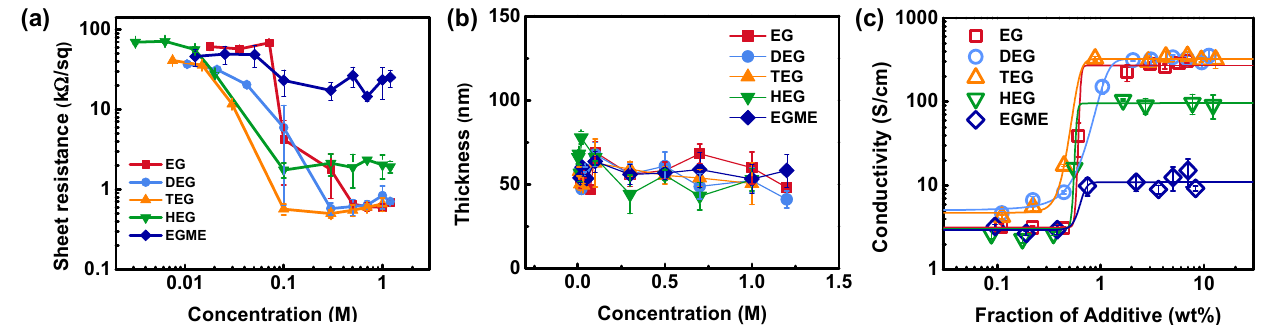
Figure 1. ( a ) Sheet resistance of poly(3,4-ethylenedioxythiophene):poly(styrene sulfonate) (PEDOT:PSS) films processed with linear glycol-based additives at various concentrations. ( b ) Film thickness of PEDOT:PSS films processed with the additives. ( c ) Electrical conductivity of PEDOT:PSS films as a function of the weight fraction of additives in the stock PEDOT:PSS dispersion. Solid lines in ( c ) are fitting curves of data with a sigmoidal logistic function as shown in Equation (1).